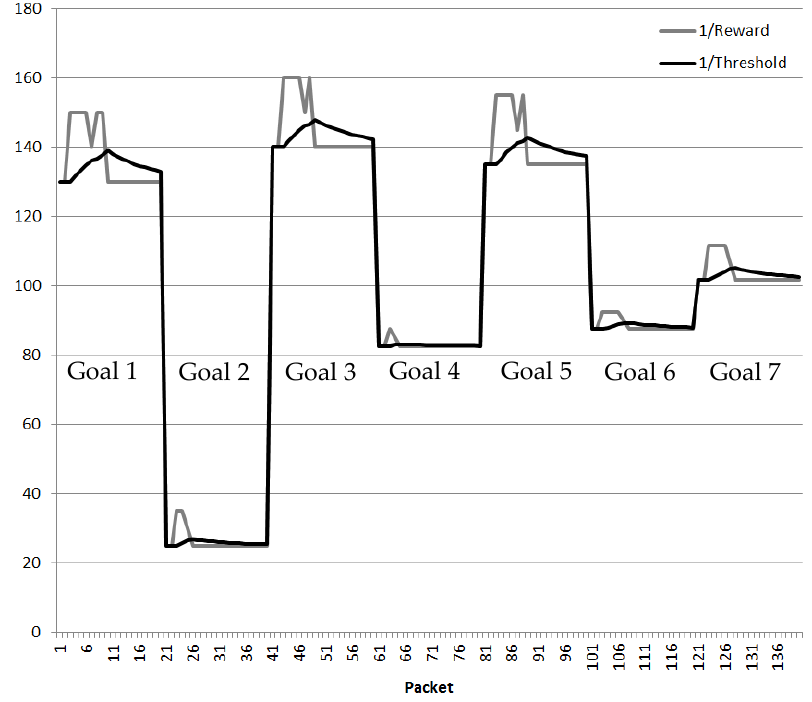
Figure 9. QoS Deep Learning cluster validation (3 × 3 Nodes).